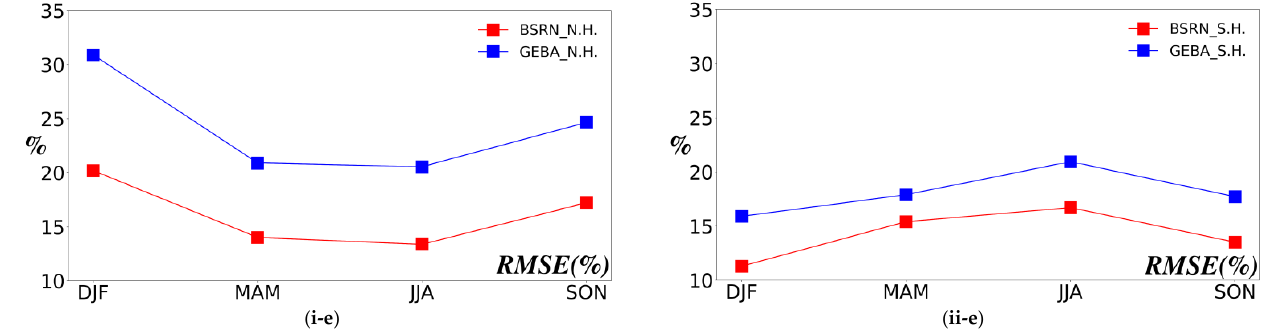
Figure 4. Seasonal variation of hemispherical averages of correlation coefficient R ( i , ii-a ), bias in W/m 2 ( i , ii-b ), percent relative bias in % ( i , ii-c ), root mean squared error (RMSE in W/m 2 ) ( i , ii-d ) and percent relative RMSE in % ( i , ii-e ) between MERRA-2 and GEBA (blue) and BSRN (red) stations, computed using SSR fluxes (except for R that is computed using deseasonalized SSR anomalies) for the North Hemisphere (( i )-left column) and South Hemisphere (( ii )-right column).